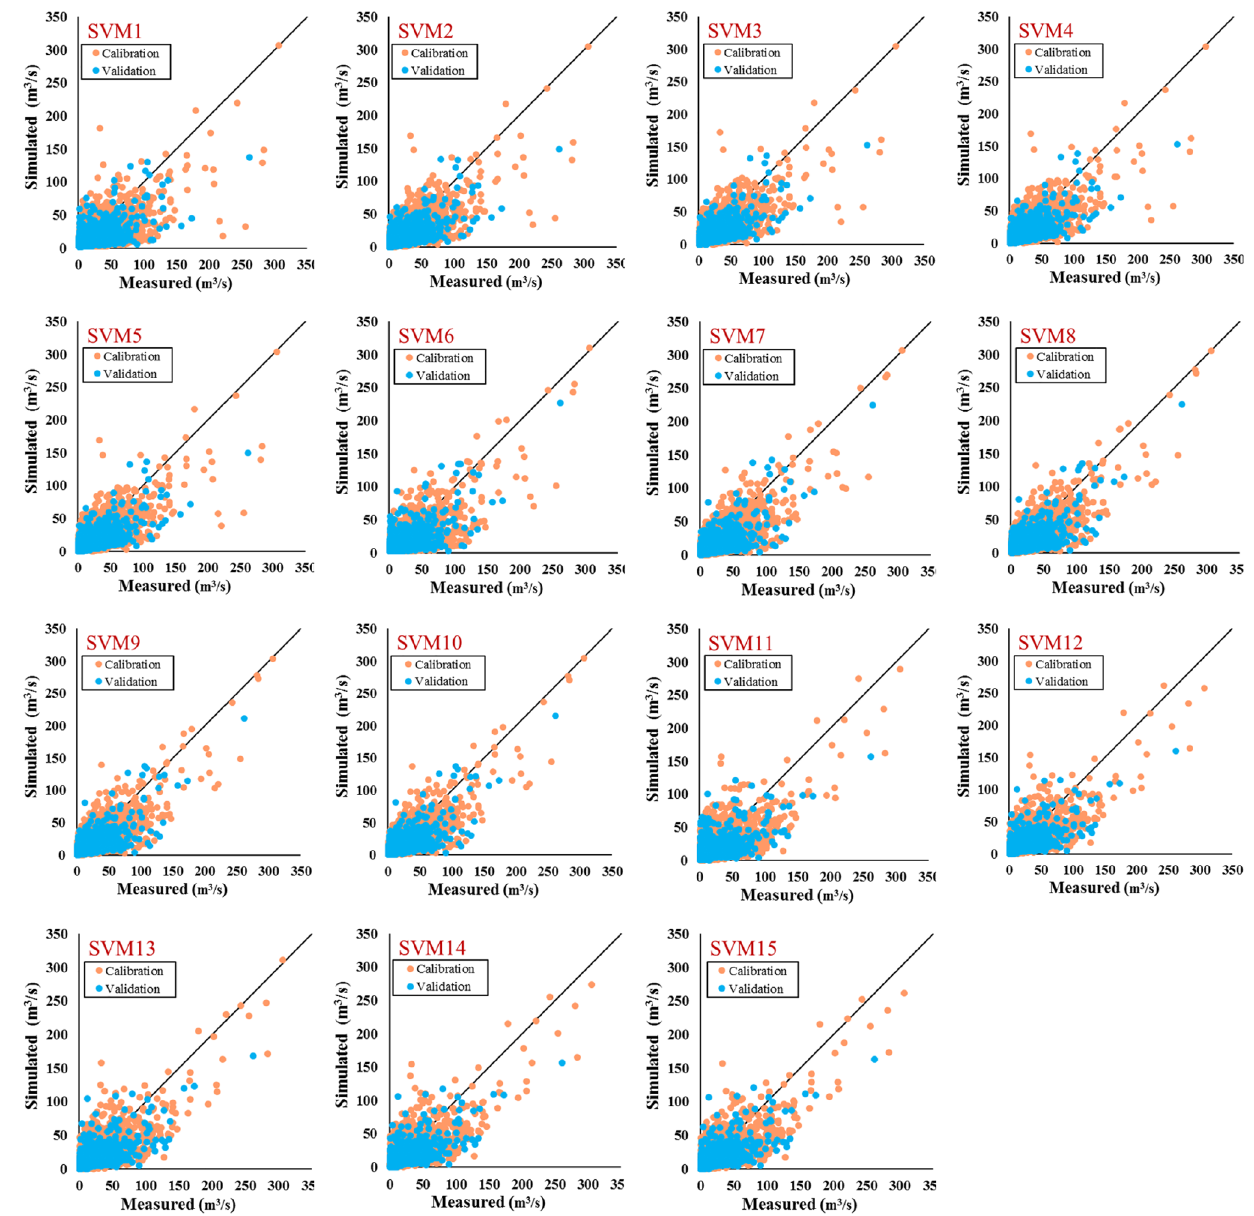
Figure 7. Scatter plots of measured vs simulated runoff of the calibration and validation phases through the different SVM